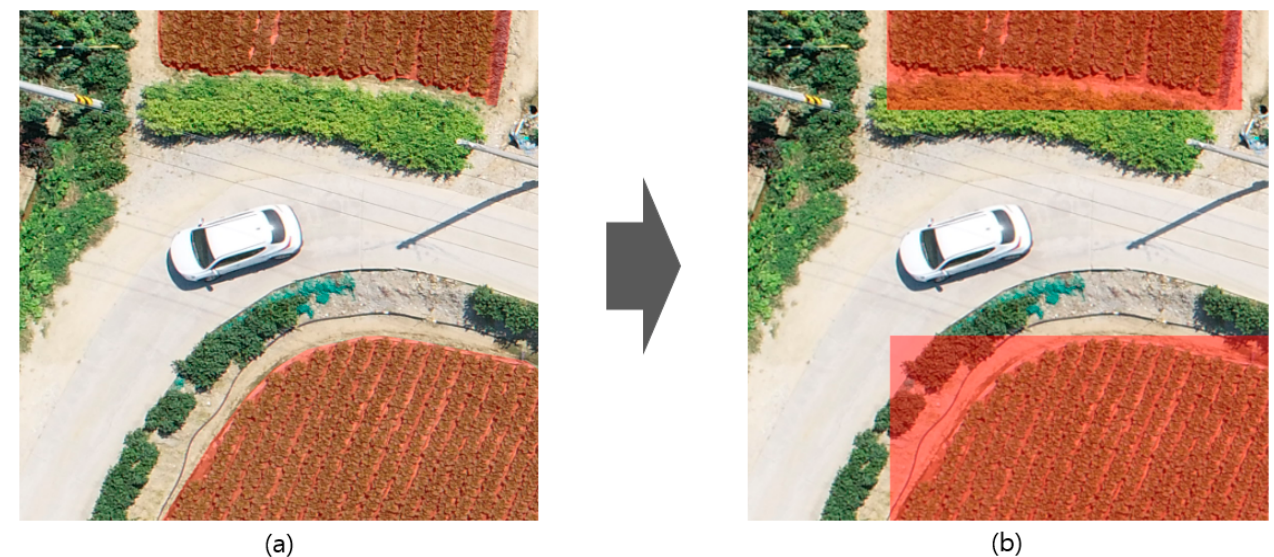
Figure 10. Conversion from polygons to bounding boxes: ( a ) polygon; ( b ) bounding box.